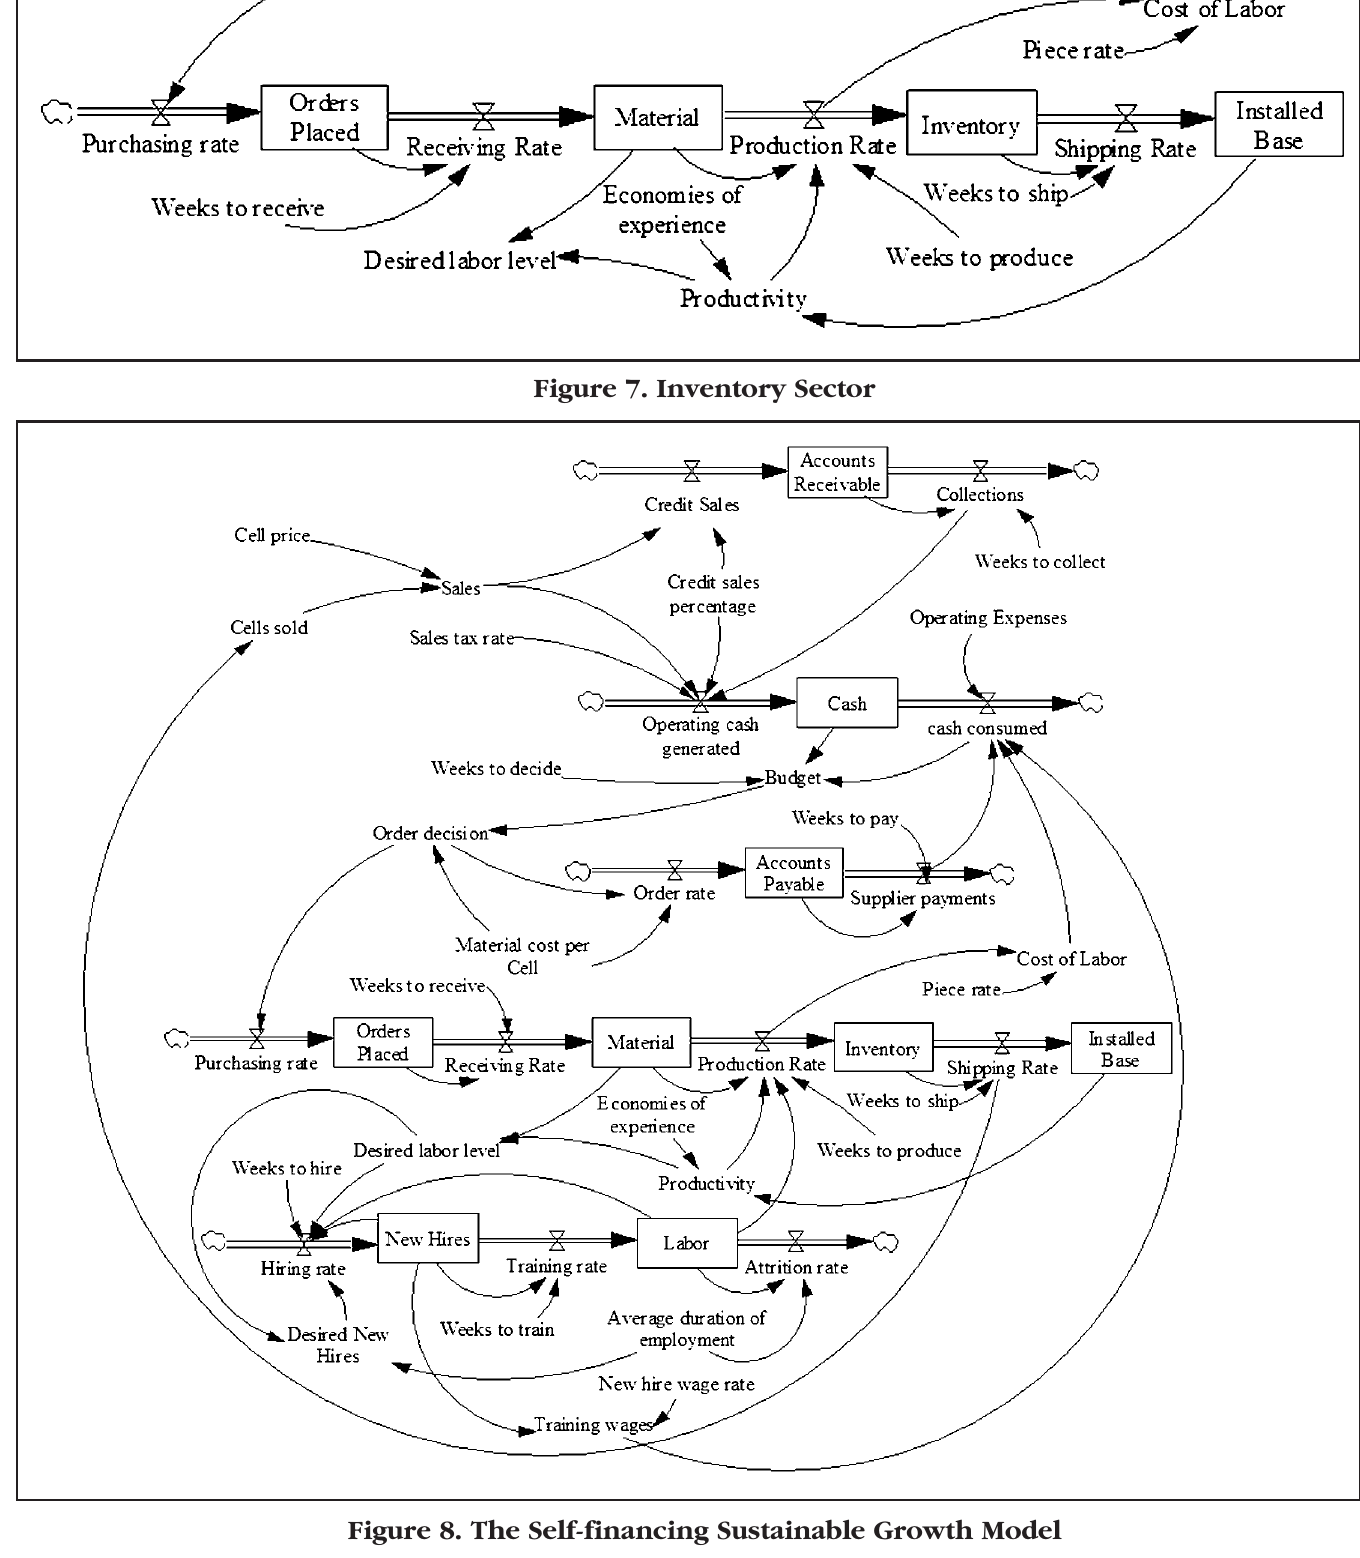
Figure 8. The Self-financing Sustainable Growth